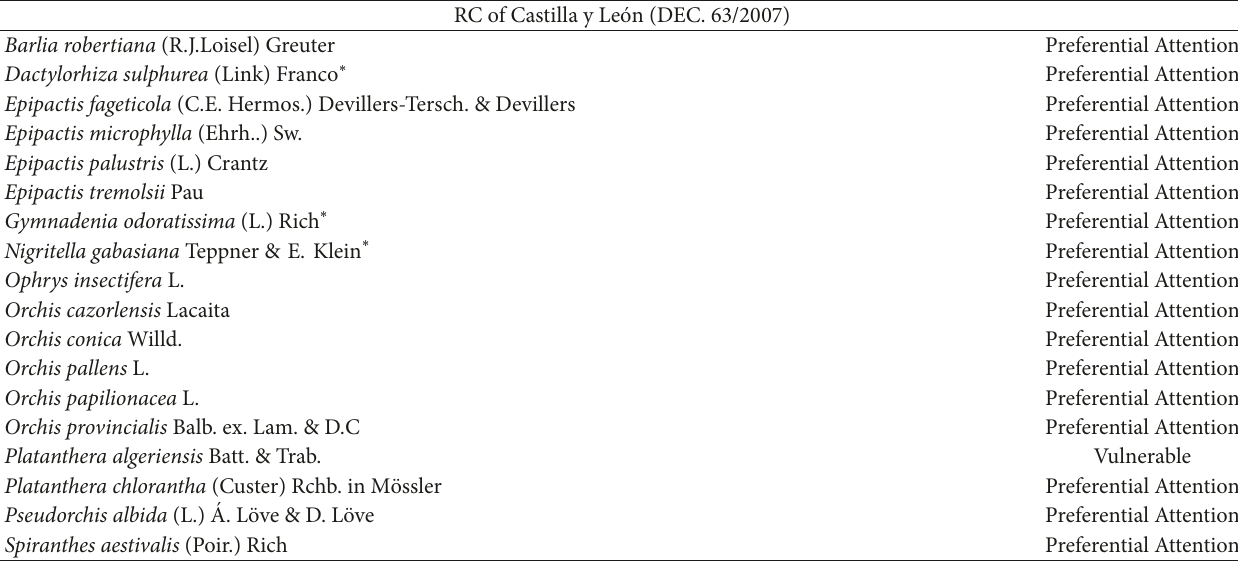
Table 12: Species included in the regional catalogue (RC) of Castilla y Le´on (DEC. 63/2007). RC of Castilla y Le´on (DEC.